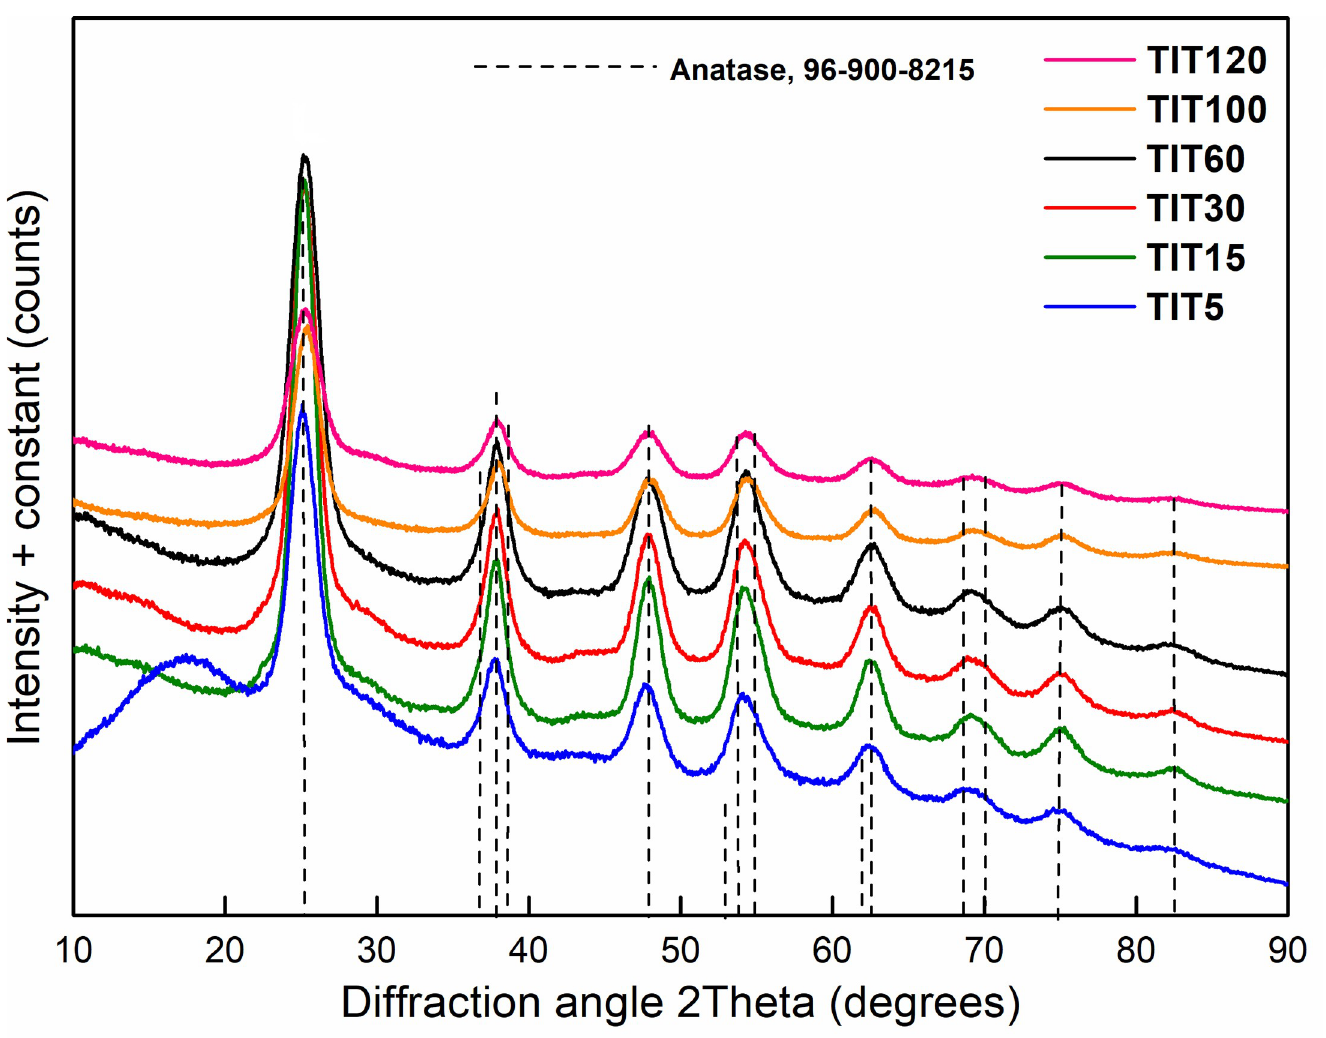
Fig 3. The XRD patterns of the titanium